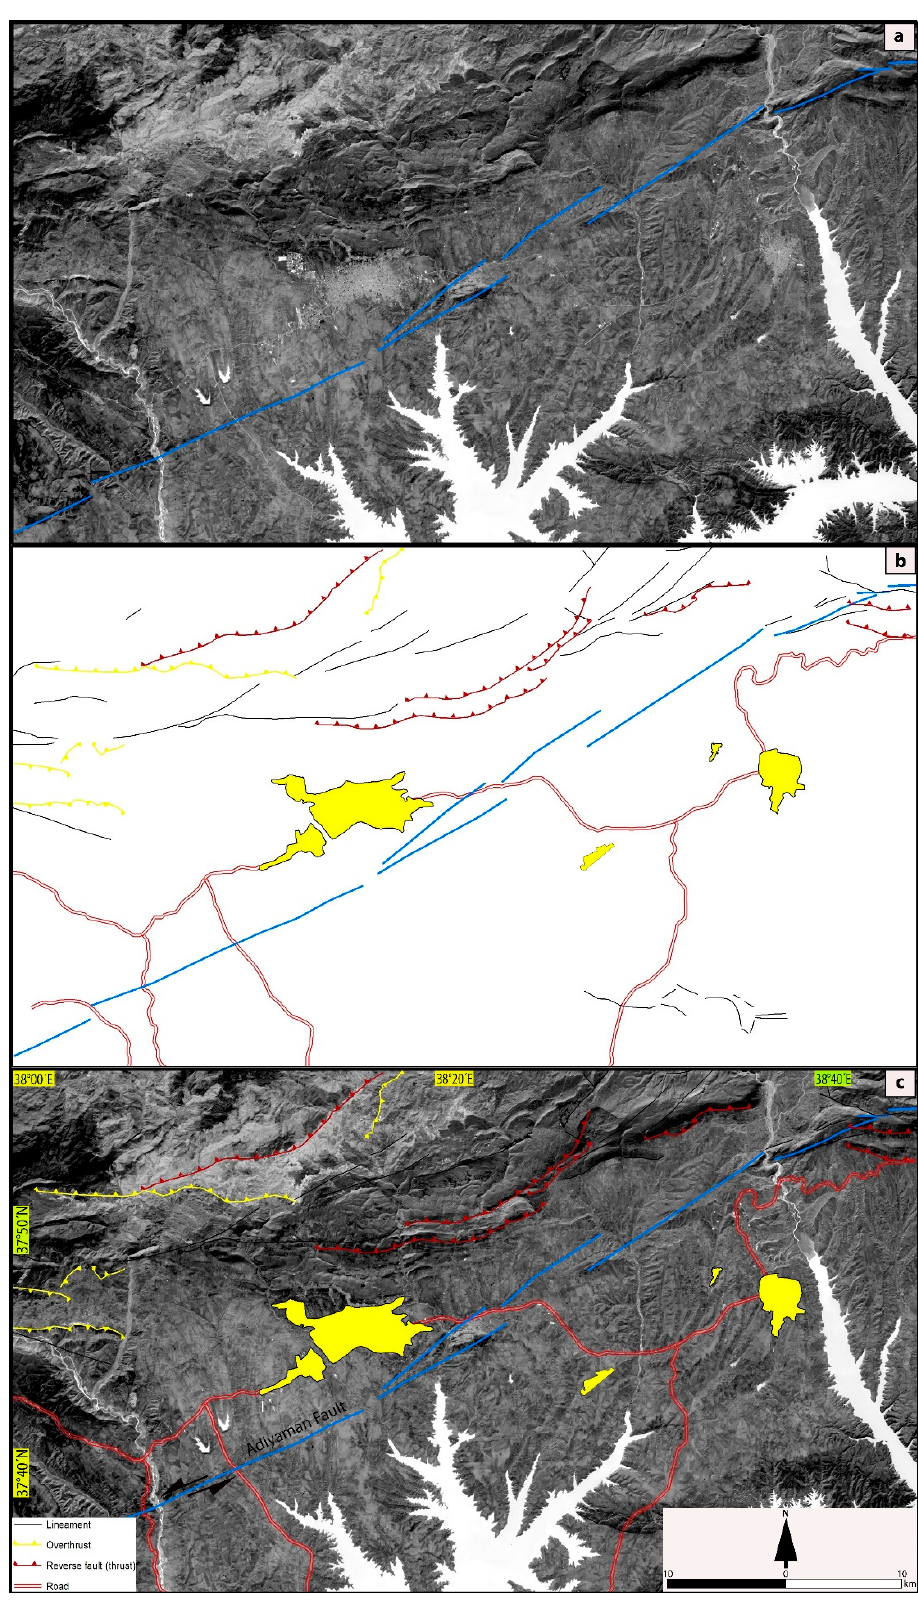
Figure 7. ( a ) Landsat 8 MNFA band 1; ( b ) structural map of the study region; ( c ) structural map layer over MNF band 1. Areas of settlements are defined by yellow